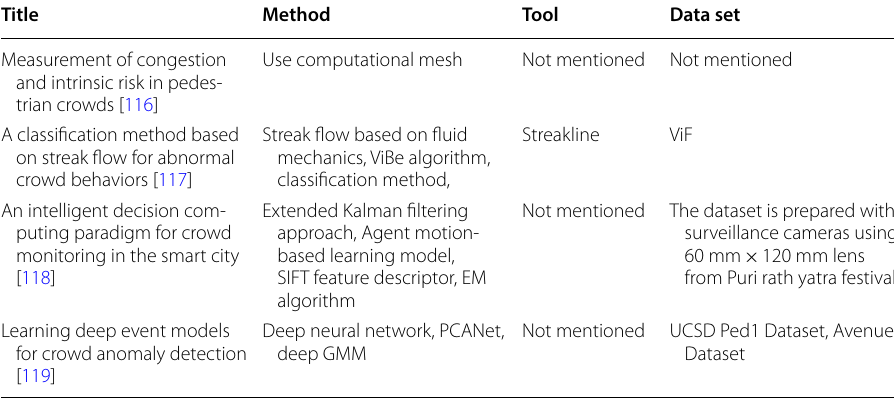
Table 10 Crowd analysis